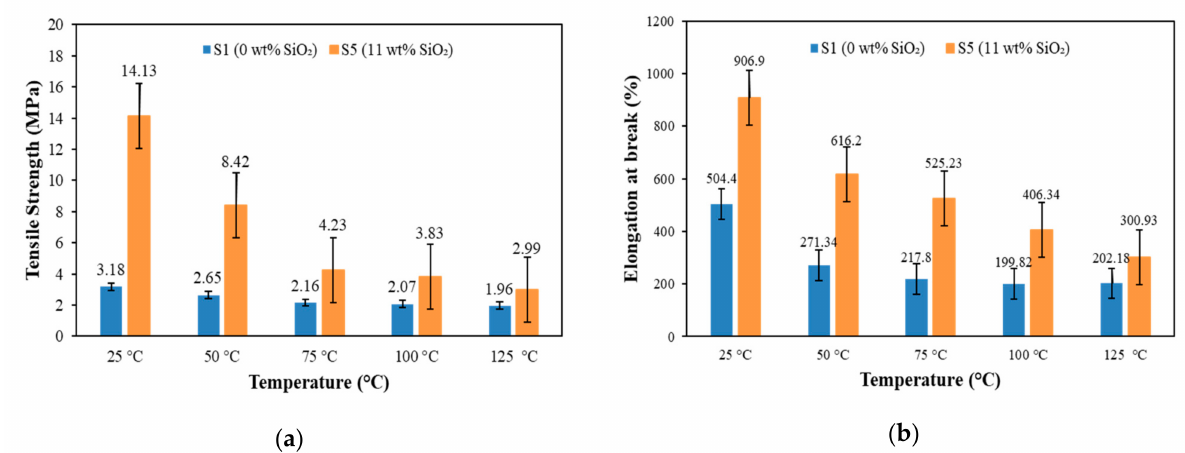
Figure 6. Tensile properties of EPDM-based MREs: ( a ) tensile strength and ( b ) elongation at break at different temperatures for sample S1 and